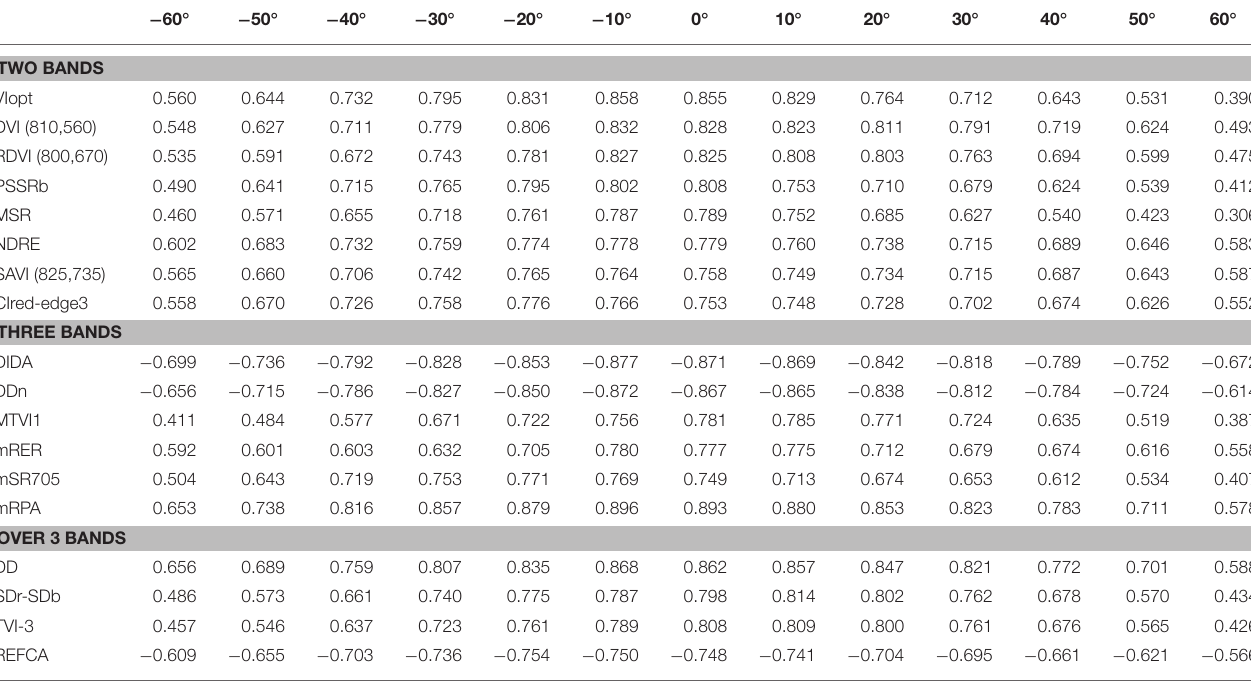
TABLE 3 | The correlation coefficient ( r ) for the relationships of vegetation indices with aerial N uptake at different viewing zenith angles ( n = 155, p 0.001 = 0.262).